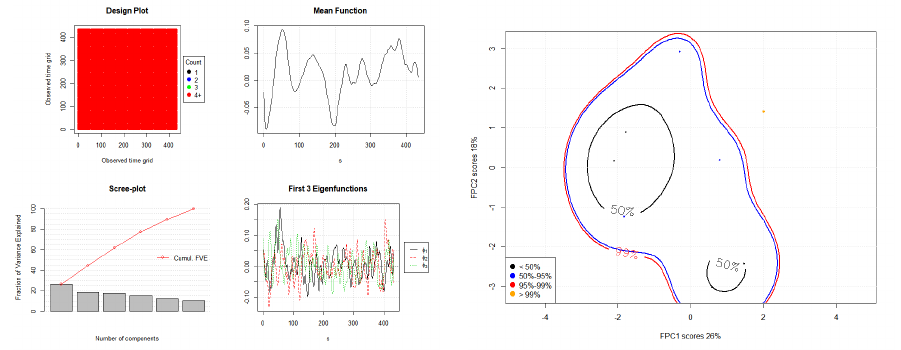
Figure 7. FPCA lots of Europe (1/3/2013 to 10/6/2014).